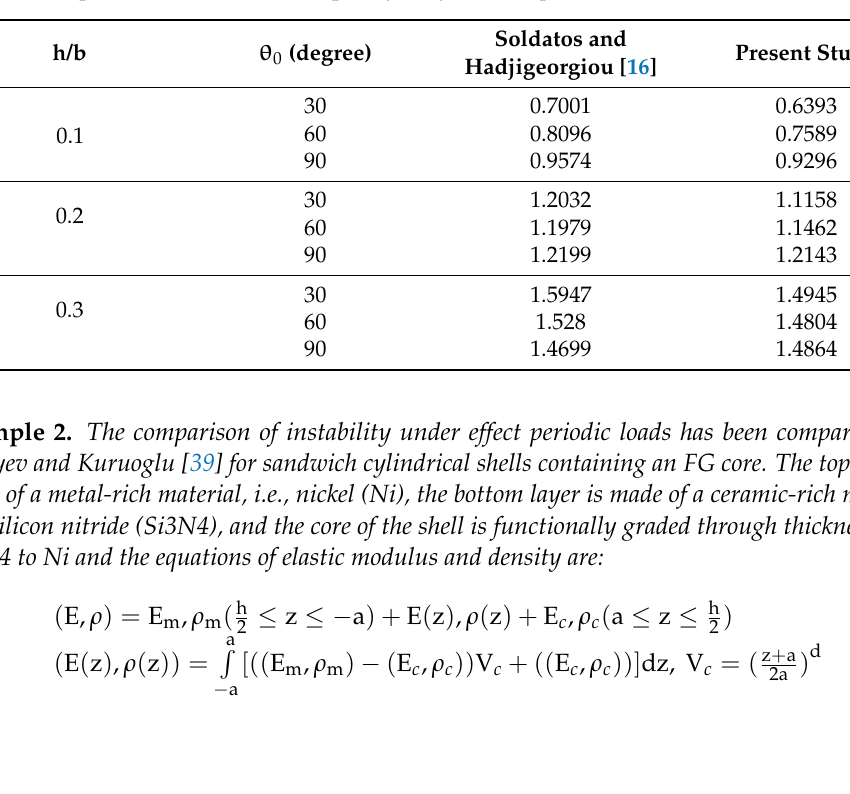
Table 1. Comparison of the natural frequency of cylindrical panels. h/b θ 0 (degree)